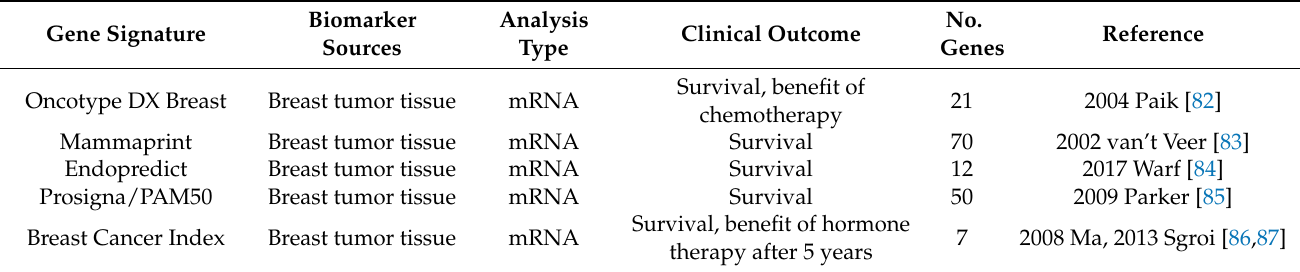
Table 2. Summary of breast cancer commercially available gene expression